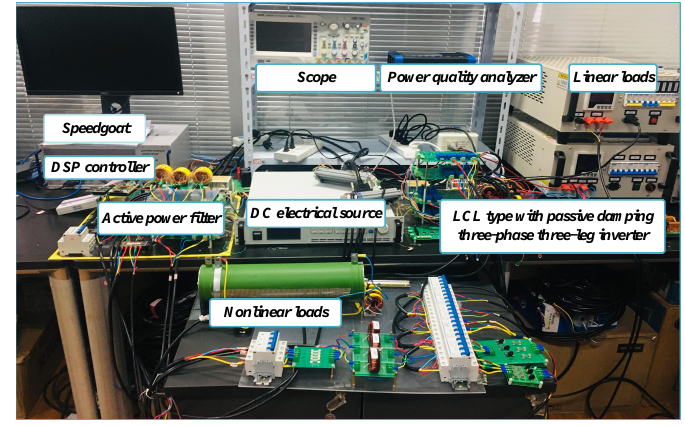
Figure 15. Experimental hardware platform. Table 5. Experimental circuit parameters.